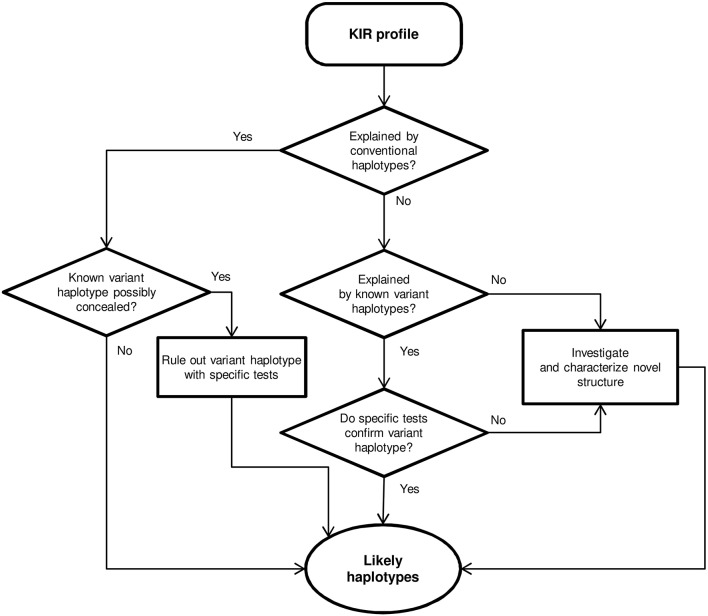
Flowchart for haplotype estimation from KIR-gene profiles.